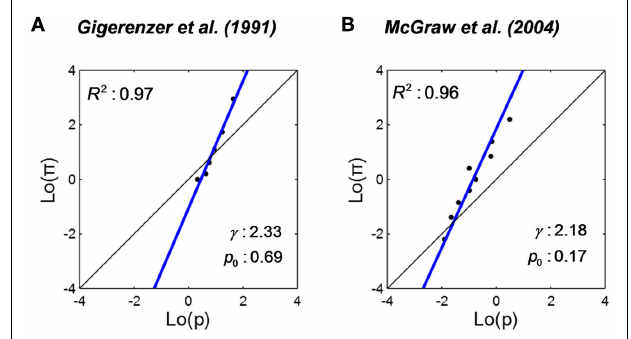
FIGURE 5 | Linear in log odds fits: confidence rating for cognitive and motor responses. Estimated probability of being correct or successful is plotted versus the actual probability on log odds scales and fitted by the LLO function. Black dots denote data.The blue line denotes the LLO fit. R 2 denotes the proportion of variance accounted by the fit. (A) Estimated probability of being correct in general-knowledge questions from Gigerenzer et al. (1991). Participants first chose an answer for two alternative general-knowledge questions and then indicated the probability that the answer was correct. (B) Estimated probability of success in basketball shooting from McGraw et al. (2004). Participants rated their probability of success before each basketball